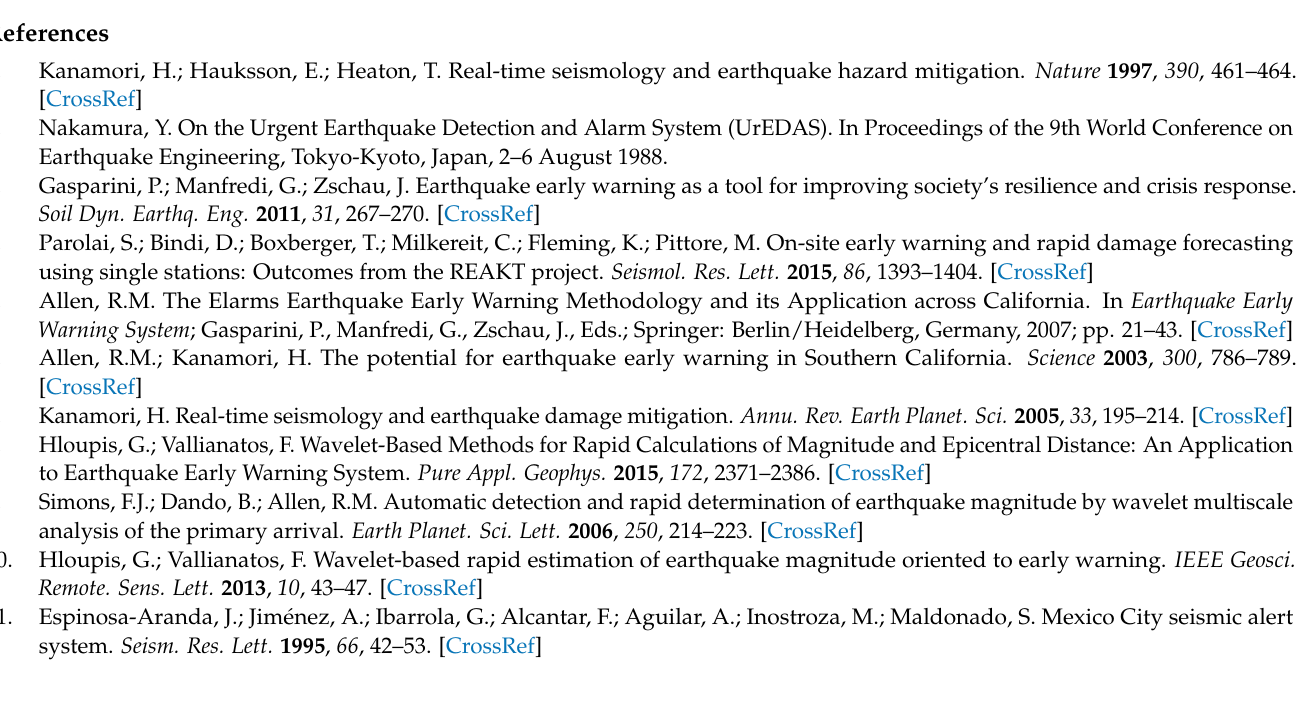
Figure A2. Residuals between predicted (M pred ) and observed (M obs ) magnitudes for the whole dataset, for signal windows of 3 s ( a ), 4 s ( b ) and 5 s ( c ).